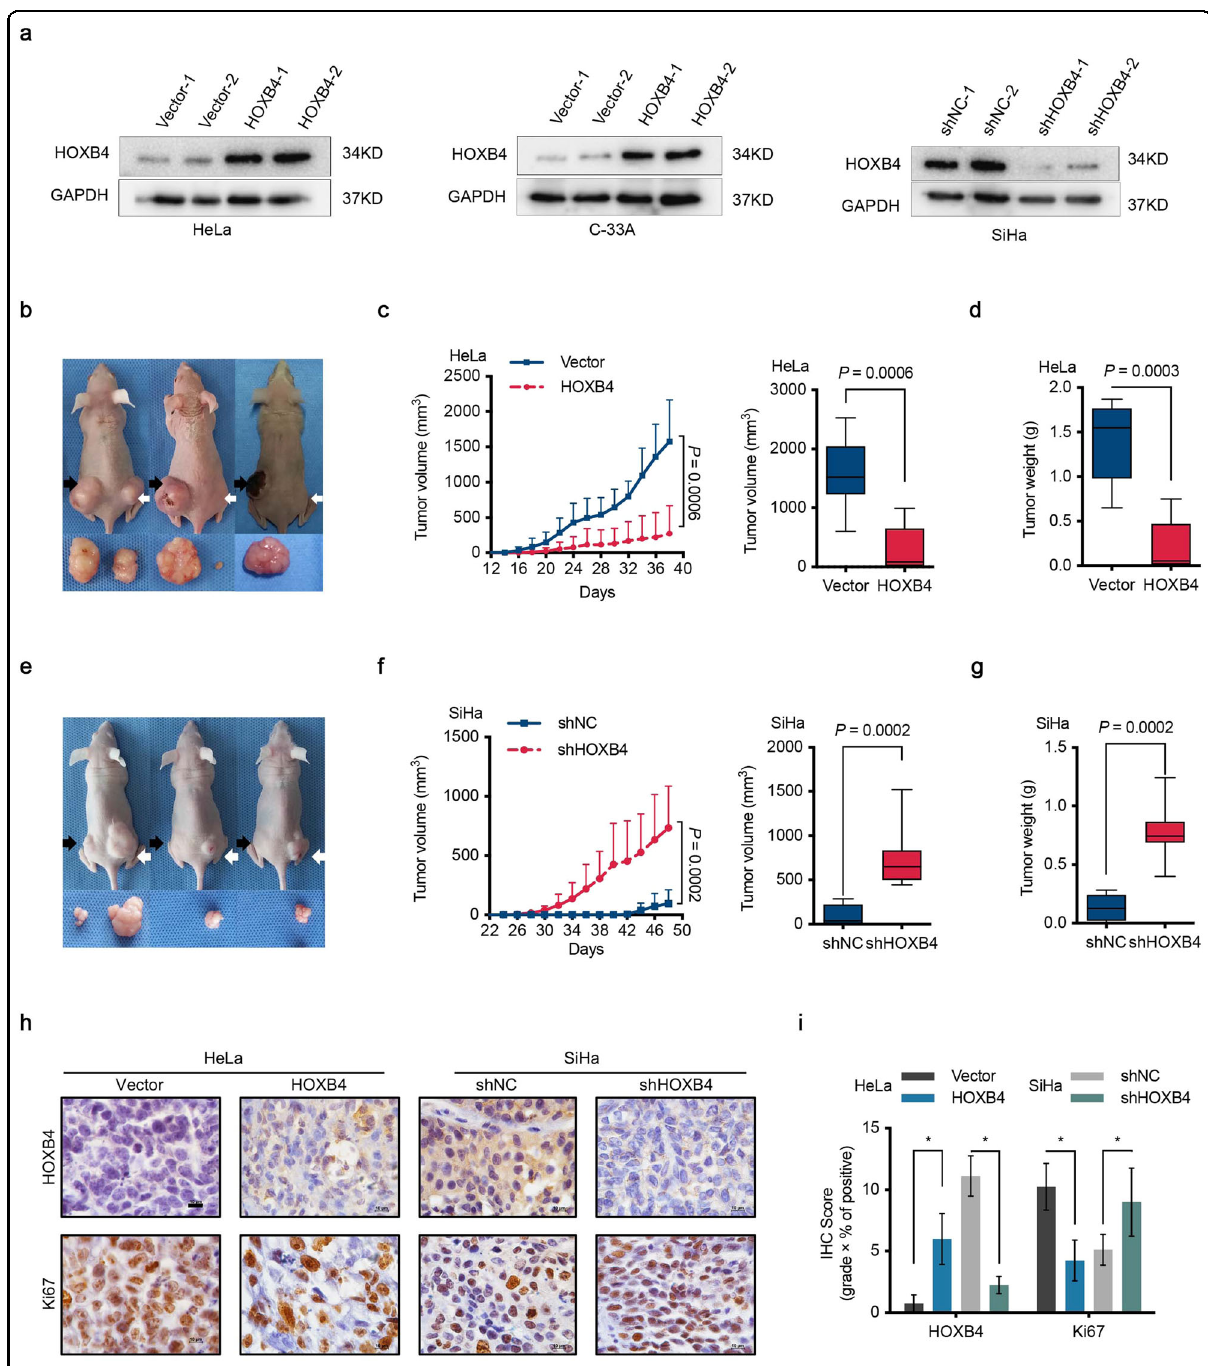
Fig. 2 HOXB4 suppressed cervical tumorigenesis in vivo. a HOXB4 expression in modi fi ed cervical cancer cell lines. HOXB4 protein expression in HeLa ( a , left) and C-33A ( a , middle) cells transfected with either empty vector (Vector) or HOXB4 overexpression vector (HOXB4) plasmid. SiHa ( a , right) cells were transfected with either control (shNC) or shRNAs targeting the HOXB4 (shHOXB4) plasmid and detected using WB. GAPDH was used as a loading control. b – g Suppression of tumorigenesis by HOXB4. Each mouse ( n = 8 biologically independent samples) was subcutaneously injected with 1 × 10 6 HeLa cells into the left ( b black arrows, Vector) and right ( b white arrows, HOXB4). SiHa cells were also injected ( e left: black arrows, shNC; right: white arrows, shHOXB4). At the end of the experiment, mice were killed and tumors were harvested. Representative images of mice and tumors were shown ( b , e ). Tumor volumes (mm 3 ) ( c , f ) and tumor weight (g) ( d , g ) were plotted. h – i Expression of Ki67. Immunohistochemical staining was performed with HOXB4 and Ki67 ( h ) from mouse xenograft tumors and quanti fi cation by IHC scores ( i ). Representative images ( h ) were shown. Scale bar: 10 μ